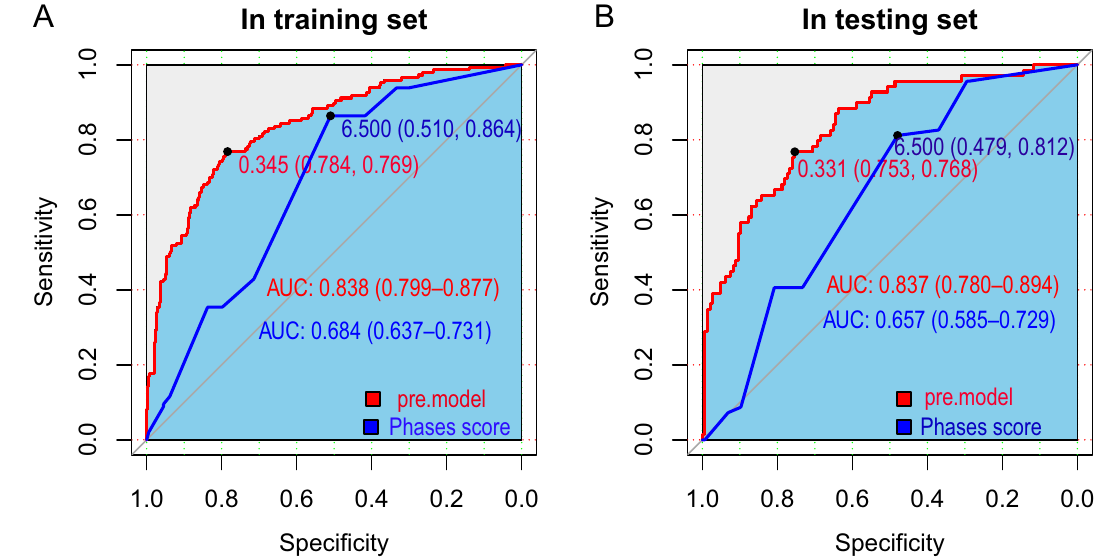
Figure 4. Discrimination of ruptured and unruptured aneurysms by the nomogram and PHASES score. ROCs were built to compare the performance of the nomogram and PHASES score in discriminating ruptured and unruptured aneurysms by comparing the AUCs in the training ( A ) and testing ( B ) sets. AUC: areas under the curve; Pre.model: the nomogram predicted risks; Phases score: the PHASES score; ROC: Receiver operating characteristic curve.